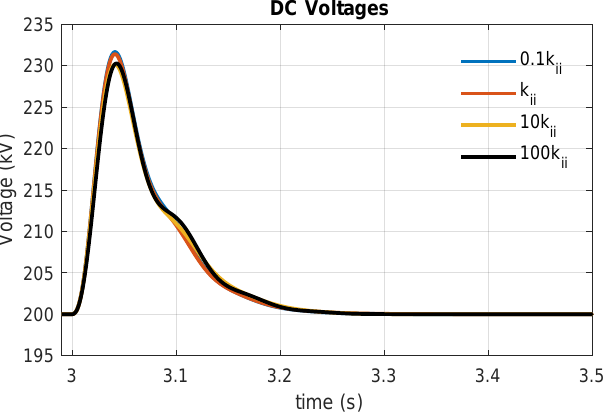
Figure 20. Time domain plot of grid side DC voltage to sensitivity of inner-controller integral gain, k ii